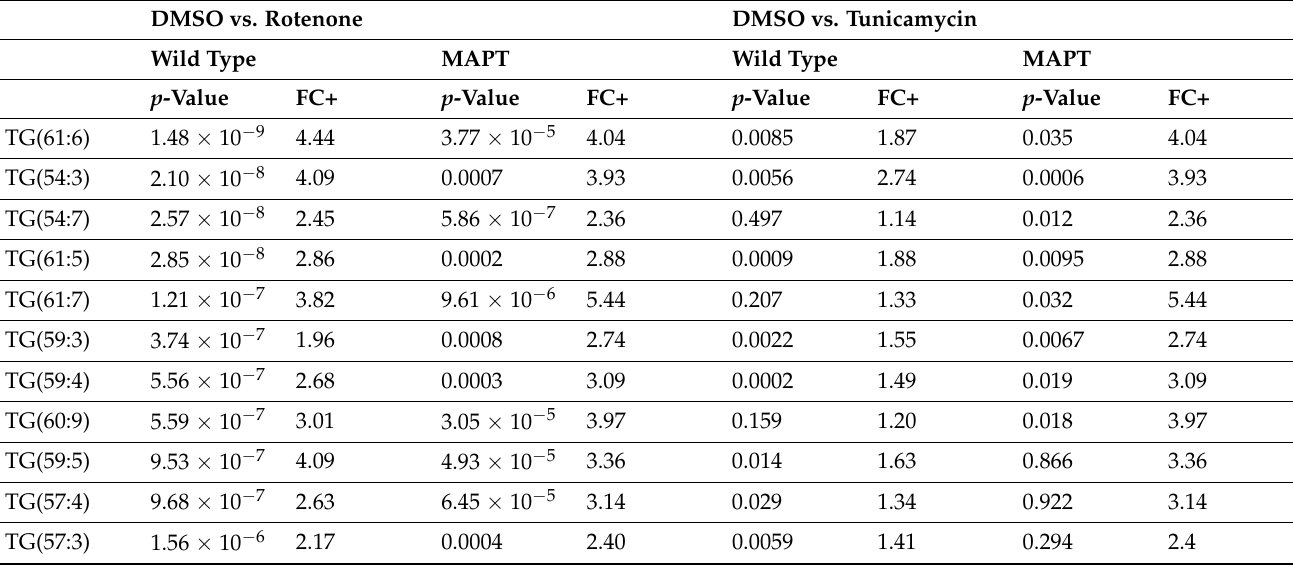
Table 3. Annotated triglycerides that accumulate in response to Rotenone and Tunicamycin treatment in both wild type and MAPT mutant dopamine neurons. DMSO vs.